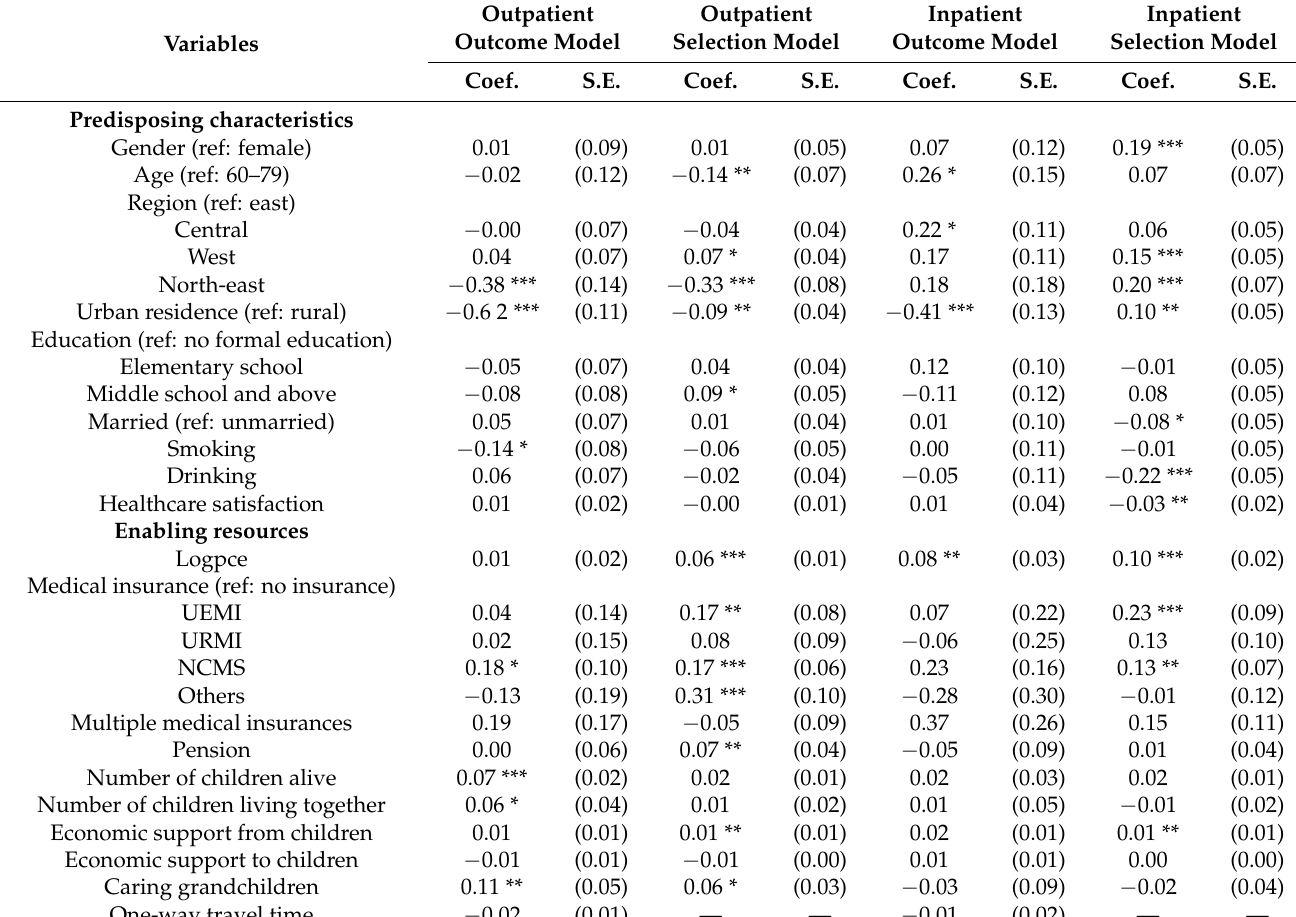
Table 5. Results of the Heckman model on the determinants of visiting primary healthcare